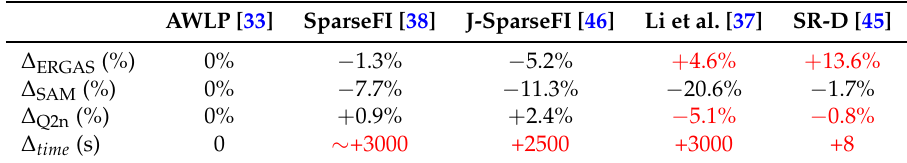
Table 1. Performance comparison on IKONOS and WorldView-II data of recent SR-based pan-sharpening methods with respect to AWLP [33]. The computation time for the J-SparseFI refers to an implementation on a 128-core computer [46].